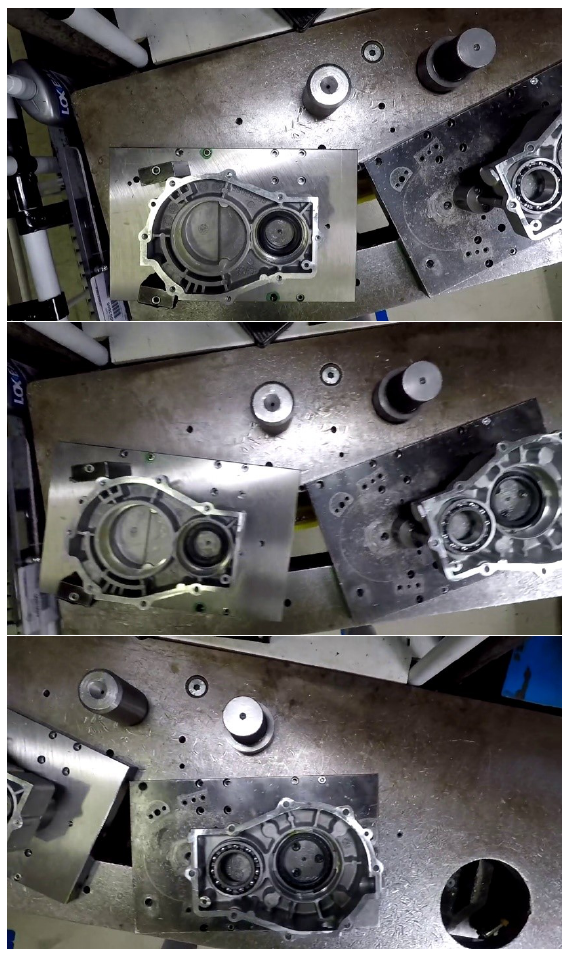
Figure 17. Camera point of